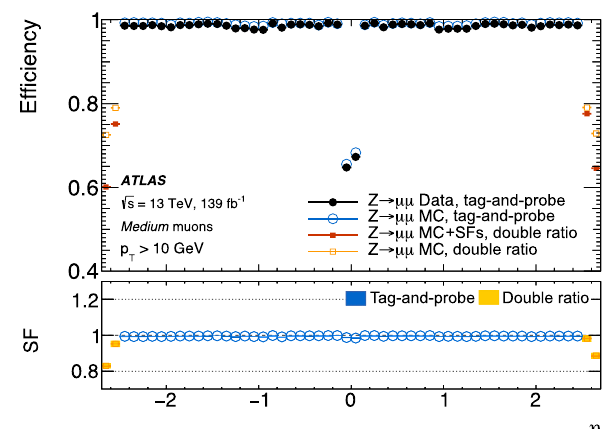
Fig. 17 Muon reconstruction and identification efficiencies for the Medium criteria measured in Z → μμ events as a function of η for muons with p T > 10 GeV. Circular markers show the results obtained using the tag-and-probe method for | η | < 2 . 5, while square markers represent the MC simulation efficiencies for | η | > 2 . 5 before and after the SFs computed with the double-ratio method are applied. The pre- dicted efficiencies are depicted as open markers, while filled markers illustrate the efficiencies resulting from a direct measurement in col- lision data ( | η | < 2 . 5), or from the application of the measured SFs ( | η | > 2 . 5). The data efficiencies are not shown for | η | > 2 . 5 as the double-ratio method allows only the SFs to be measured. The panel at the bottom shows the measured SFs. The statistical and systematic uncertainties are smaller than the size of the markers, and thus not dis- played